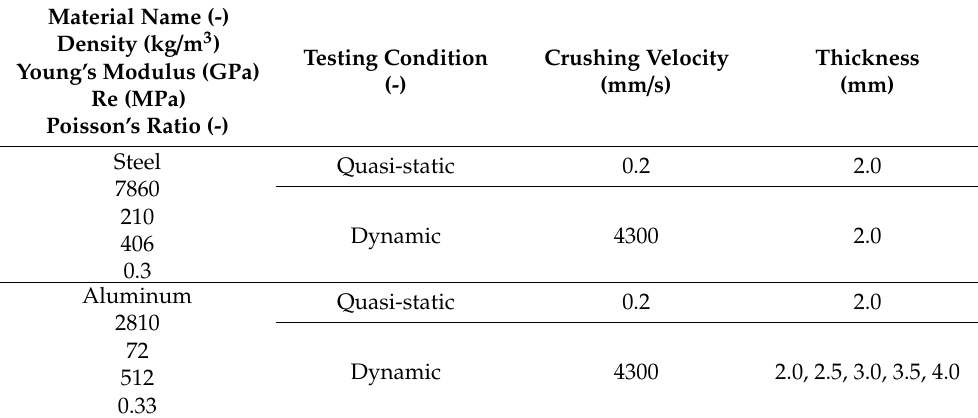
Table 1. Basic properties of tested material and the test